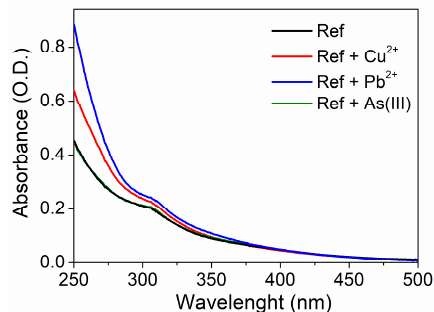
Figure 5. The UV-vis spectrum of the UFQD reference solution in the presence of Cu 2+ , Pb 2+ and As(III) ions at a concentration of 100 μ M.